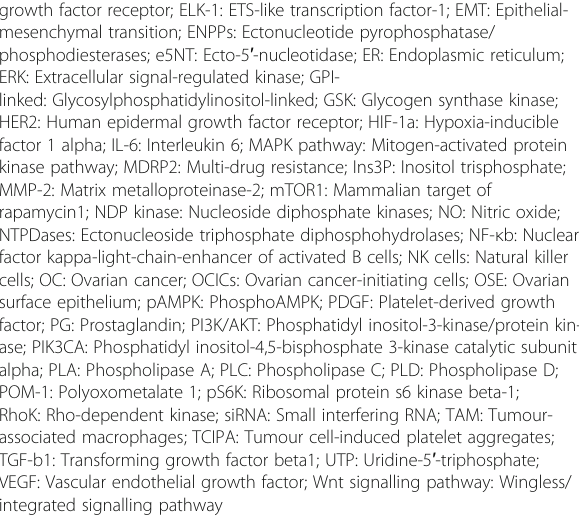
Fig. 2 Adenosine induced cytotoxicity in ovarian cancer. Adenosine generated by the presence of ectonucleotidases CD39 and CD73 activate the adenosine receptors in tumour cells. Nucleoside transporter transports this extracellular adenosine into the cell. Inside, the cell adenosine promotes apoptosis through the caspase-3-dependent pathway. Adenosine downregulates the expression of the anti-apoptotic protein Bcl-2 and G1phase cyclin D1 and CDK4 and also, it induce the expression of pro-apoptotic Bax protein. Adenosine inhibits the cell growth by the AMPK- dependent pathway. Adenosine kinase phosphorylate the adenosine and converted into AMP results in the phosphorylation of AMPK by the upstream kinase LKB1. Activation of AMPK results in the inhibition of growth stimulatory mTOR pathway and also by decreased phosphorylation of S6K. Reduced pS6K leads to the inhibition of cell growth arrest and